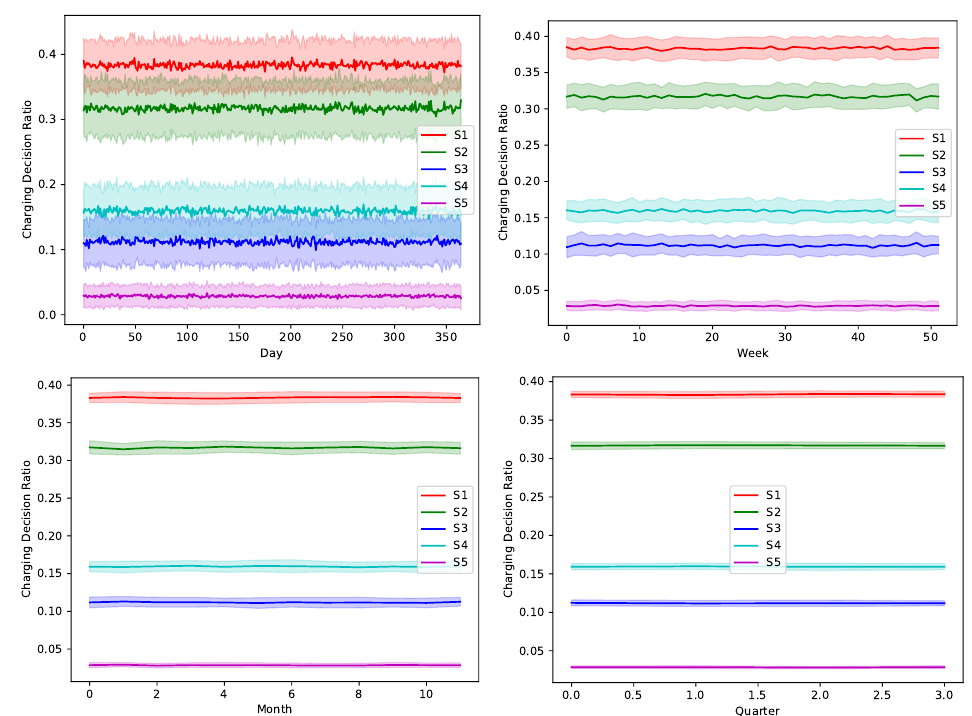
Figure 12. The temporal variation of the adopted charging decision by the greedy algorithm with a global certainty level U 95 .